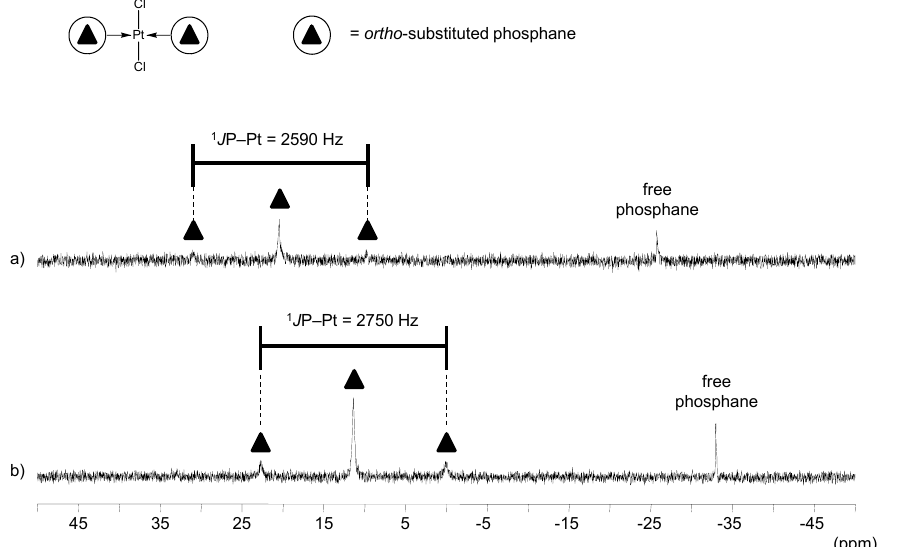
Figure 3. 31 P{ 1 H} NMR spectra of K 2 PtCl 4 (3 mM) + 3 equiv. of ( a ) tris( o -Me)TPPTS or ( b ) tris( o -OMe)TPPTS at 25 °C in D 2 O.